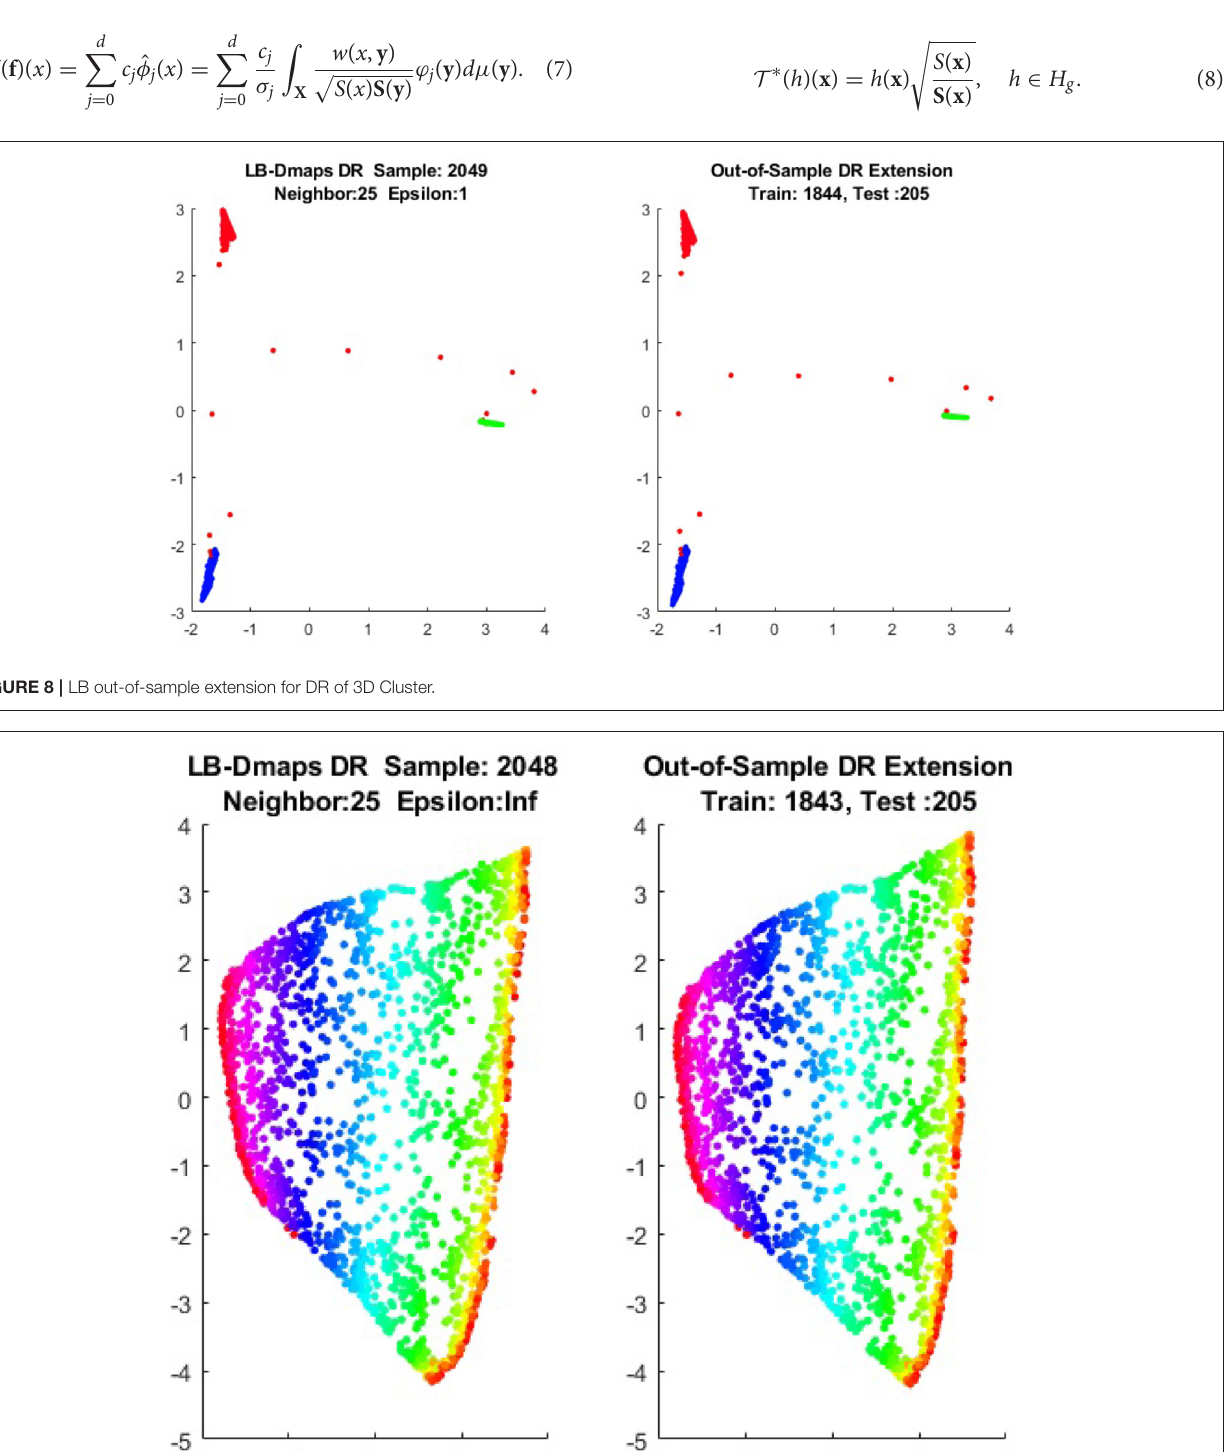
FIGURE 9 | LB out-of-sample extension for DR of Swiss